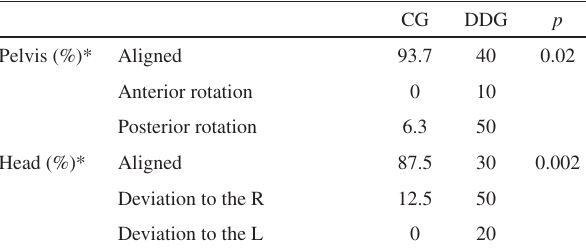
Table 2 – Postural assessments of the pelvis in the sagittal plane and of the head in the frontal